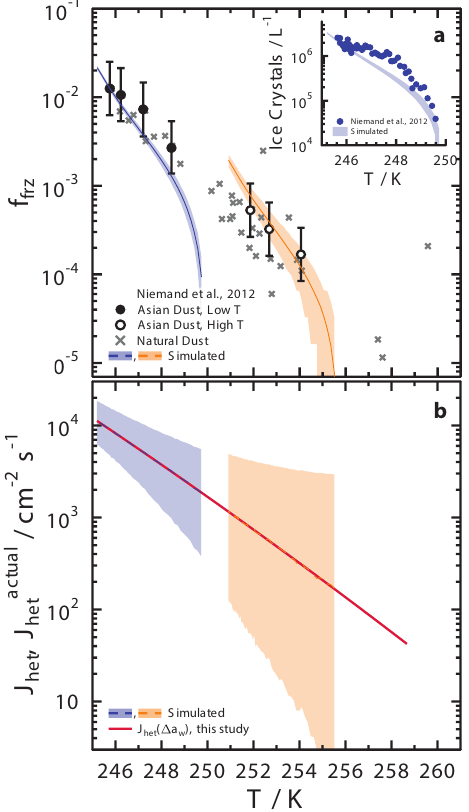
Figure 8. Frozen droplet fractions, f frz , and heterogeneous ice nu- cleation rate coefficients, J het , derived from adiabatic cooling im- mersion freezing model simulations CrNI1 (blue) and CrNI2 (or- ange). Simulated and experimentally observed ice crystal concen- trations are shown in the insert of panel (a) . Dashed lines and shad- ings in (a) are f frz and 5th and 95th percentile bounds, respec- tively. Experimentally derived f frz and uncertainties by Niemand et al. (2012) are shown as symbols and error bars. J het as a func- tion of temperature, T , is shown in (b) and accounting for variable actual ISA yielding J actual , where dashed lines and shading are J het het and fiducial limits with x = 0 . 999 confidence, respectively. The red line in (b) is calculated from Eq. (6) using new parameters derived for natural dust. Parameter values for CrNI1 and CrNI2 are given